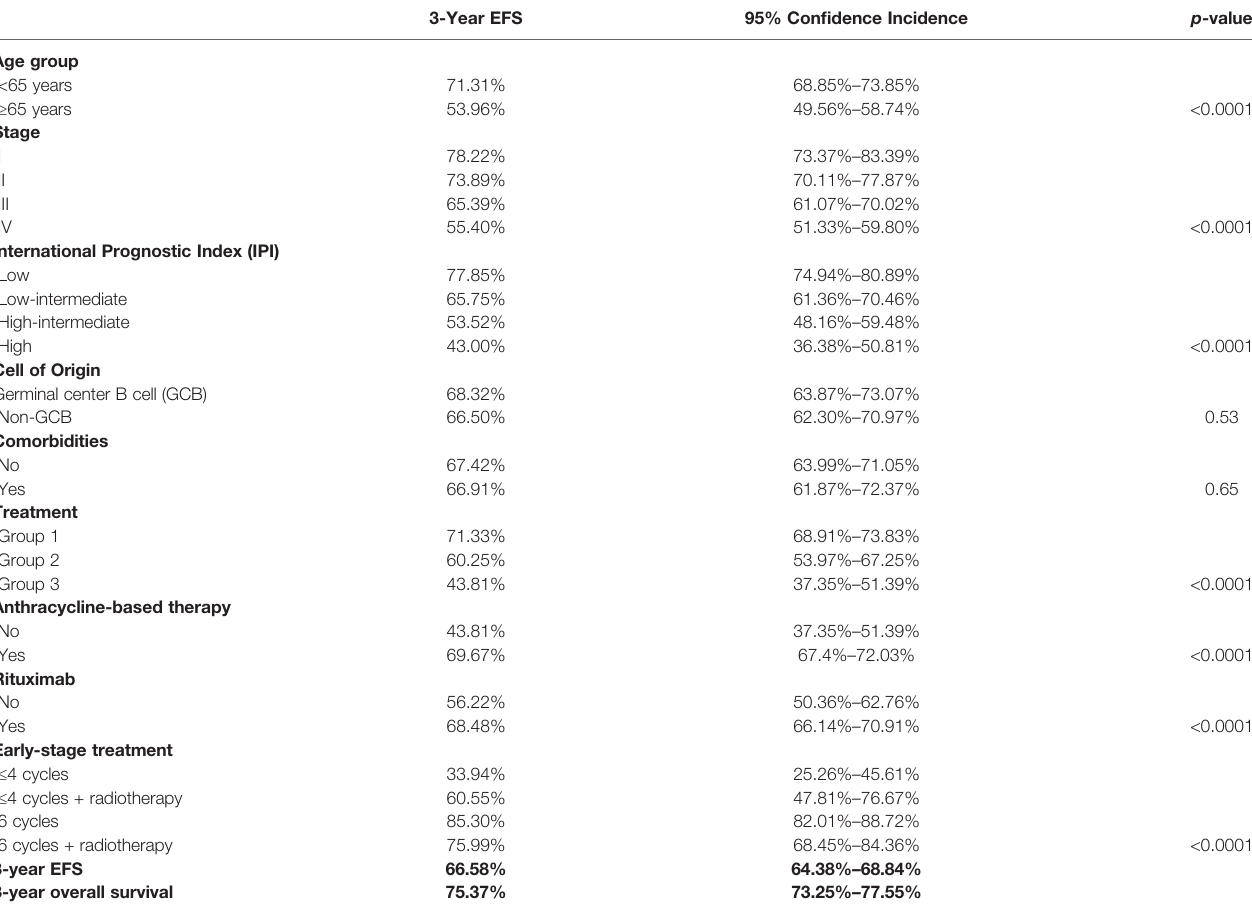
TABLE 2 | Three-year event-free survival outcomes of